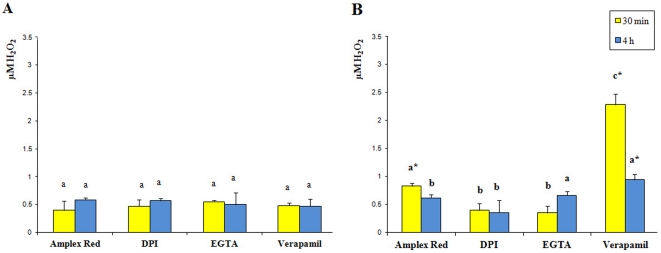
H2O2 variations in G. biloba upon mechanical damage and herbivore wounding.
A. Mechanically-wounded G. biloba leaves, values (n = 5) are expressed as µM H2O2 calculated from a calibration curve. The same letter indicates not significant (P>0.05) variation. B. Herbivore-wounded G. biloba leaves, values (n = 5) are expressed as µM H2O2. Different letters indicate significant (P<0.05) differences, the asterisk indicate significant (P<0.05) differences with respect to mechanical damage. In both panels, amplex indicates the absence of pharmacological agents.